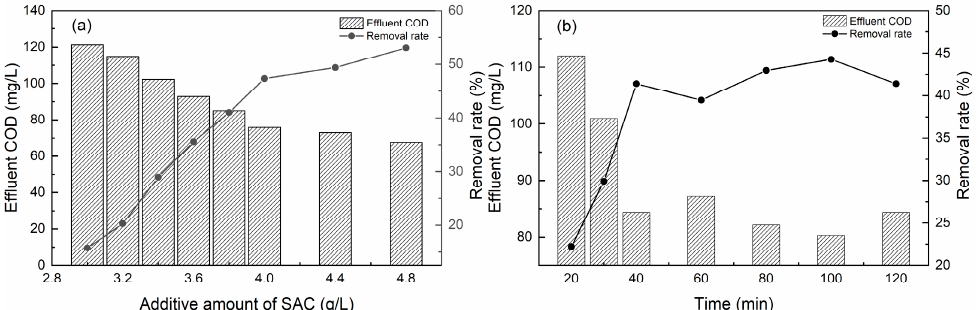
Figure 2. (a) Variable of removal efficiency of SAC dosage, (b) Variable of removal efficiency of Figure 2. ( a ) Variable of removal efficiency of SAC dosage, ( b ) Variable of removal efficiency of adsorption time. adsorption